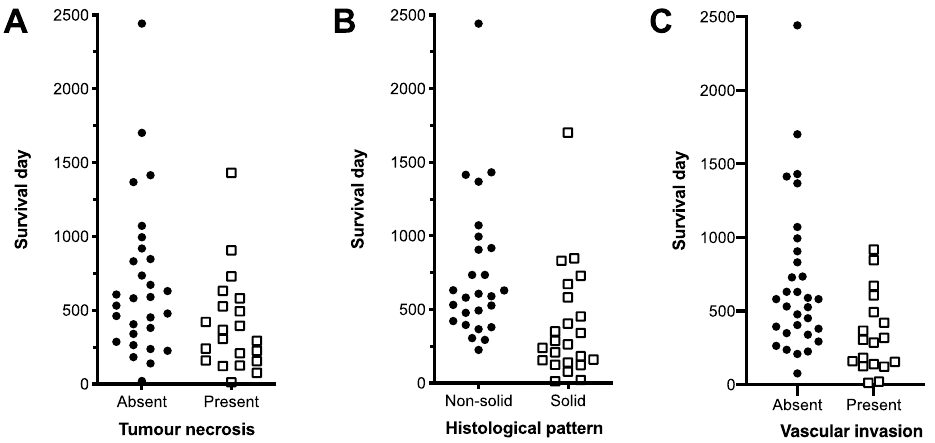
Figure 5. Histopathological variables found to be independent risk factors for poor survival in dogs with AGASAC. ( A ). Tumour necrosis. ( B ). Predominant histological pattern. ( C ). Histological evidence of vascular invasion. Table 7. Histopathological algorithm to predict survival for dogs with